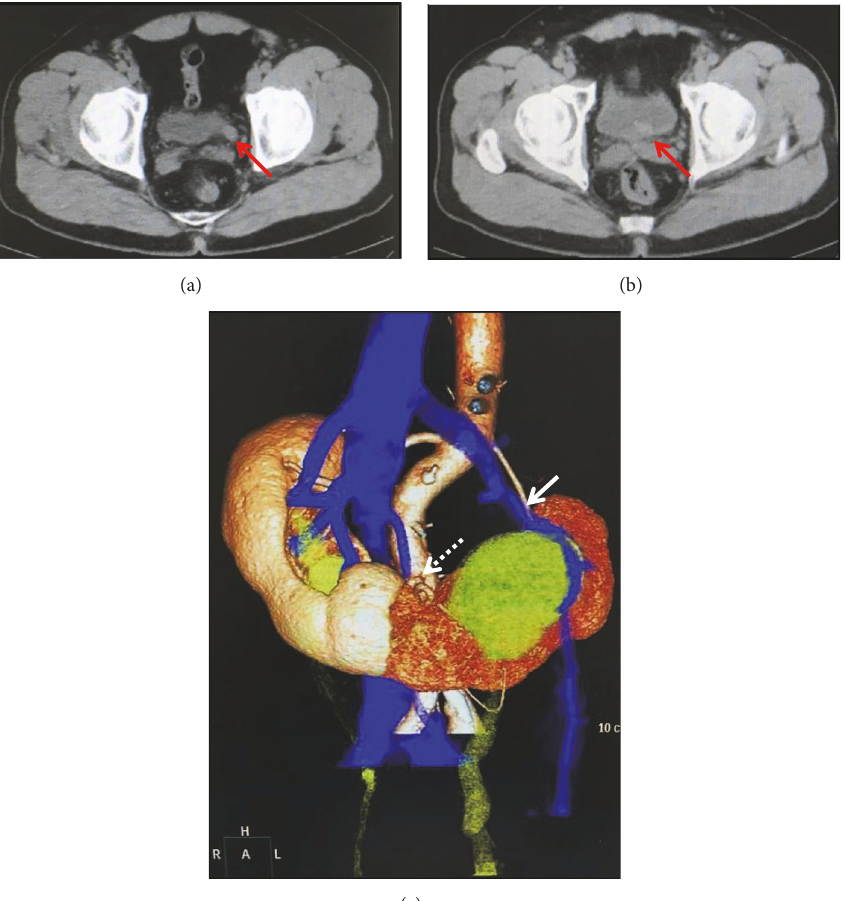
Figure 1: (a), (b) Pelvic CT images showing a left lower ureteral tumor near the ureteral orifice (red arrows). (c) Three-D CT imaging. The left renal artery (white arrow) and an aberrant renal artery (white dotted arrow) supplied the left part of the horseshoe